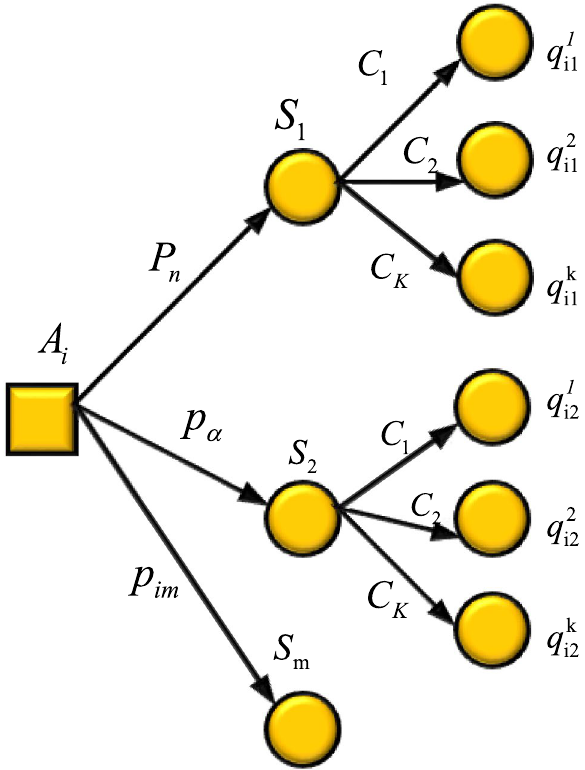
Figure 1. Multi-scenario mixed risk decision-making problem